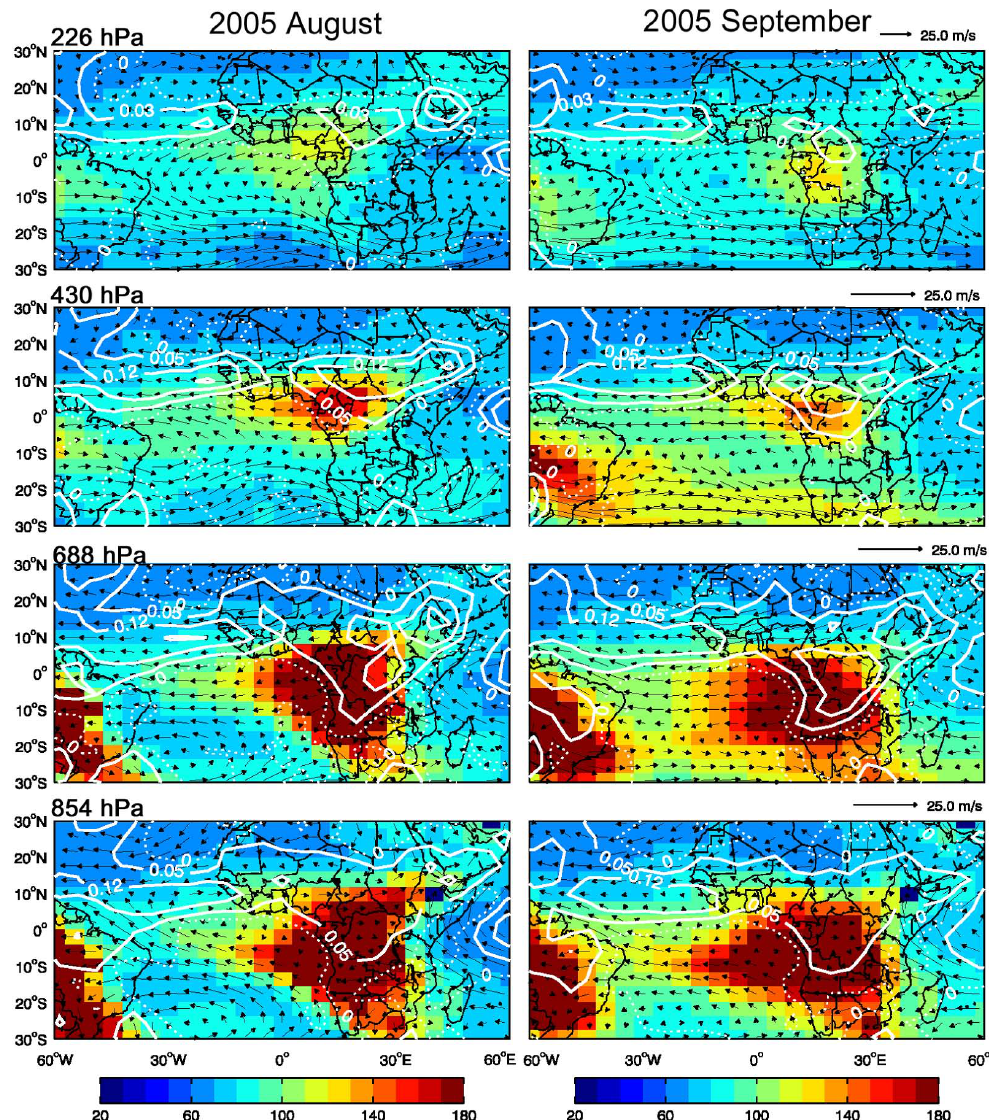
Fig. 18. CO mixing ratio (ppb) overlaid with horizontal wind vectors in August (left) and September (right) 2005 at 854, 688, 430, and 226hPa for the GEOS-4 model. The vertical air mass flux (Pas − 1 ) is shown by contours: ( − 0.05, 0, 0.05, 0.12, 0.2) for 854, 688, and 430hPa, and ( − 0.05, 0, 0.03, 0.06, 0.12) for 226hPa. Positive values are upward fluxes (solid lines), negative values are downward fluxes